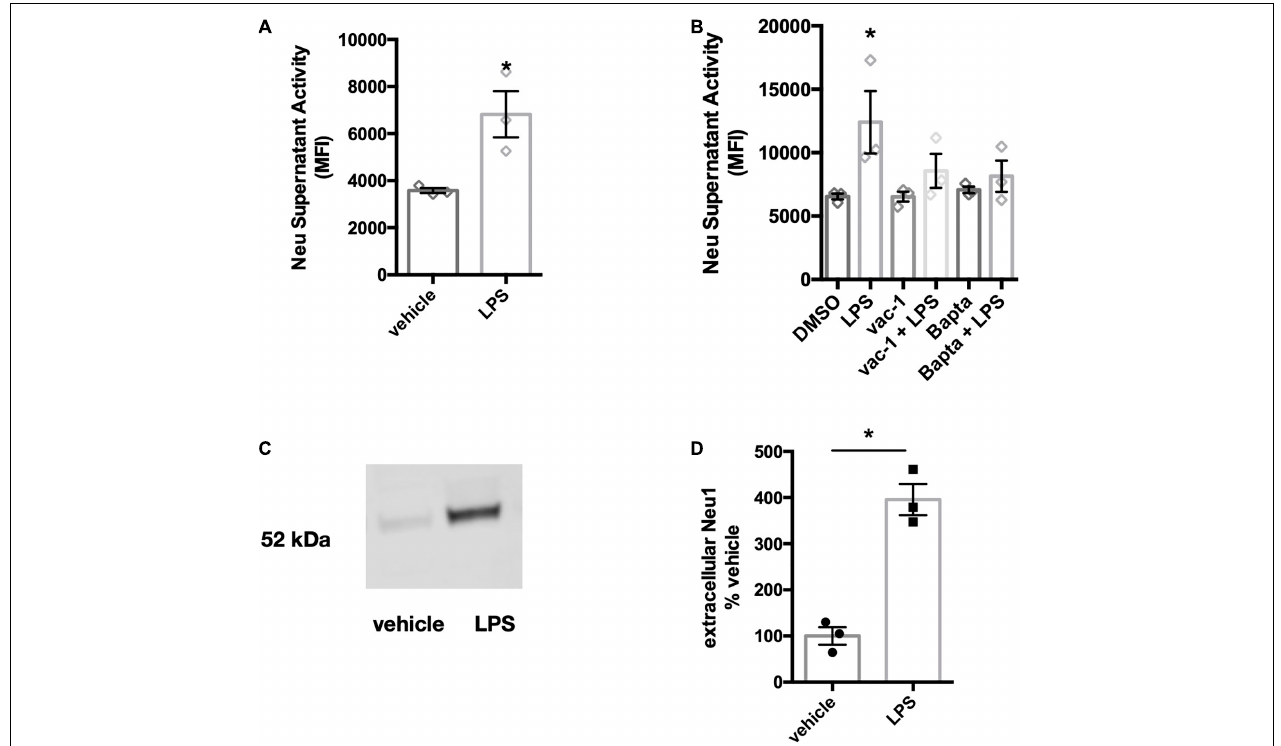
FIGURE 4 | Primary microglia treated with LPS also release neuraminidase activity and Neu1 protein. (A) Supernatant neuraminidase activity assays (pH 7.2) of vehicle or LPS-stimulated primary rat microglia (100 ng/ml LPS, 18 h). Data presented as mean neuraminidase activity assays of three independent culture preparations ( ± S.E.M). Statistics: unpaired t -test, * p < 0.05. (B) Supernatant neuraminidase activity assays (pH 7.2) of vehicle or LPS-treated (1 µ g/ml, 6 h) primary rat microglia. Cells were pre-treated for 1 h with inhibitors vacuolin-1 (400 nM) or BAPTA-AM (10 µ M). Data presented as mean fluorescence intensities of